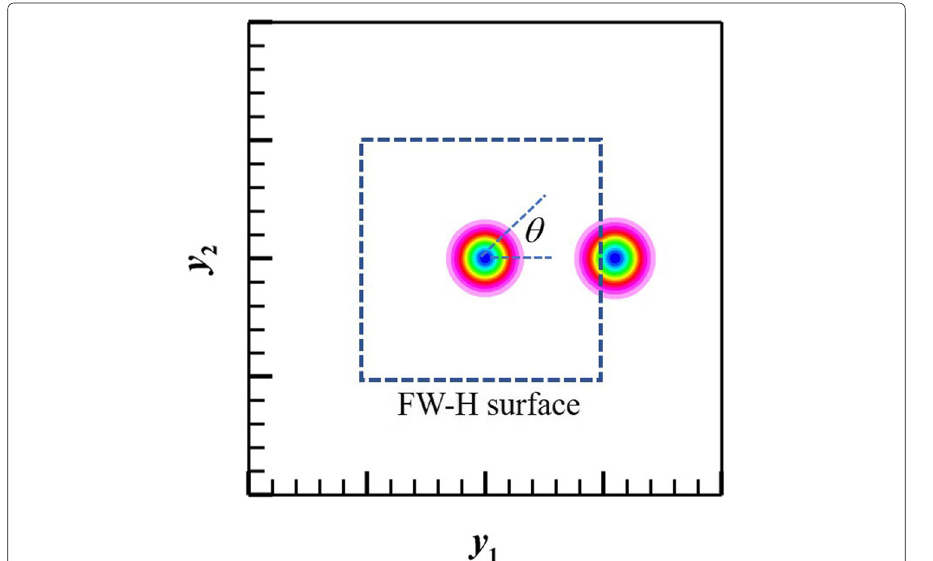
Fig. 1 Instantaneous pressure fluctuation field generated by a convecting vortex